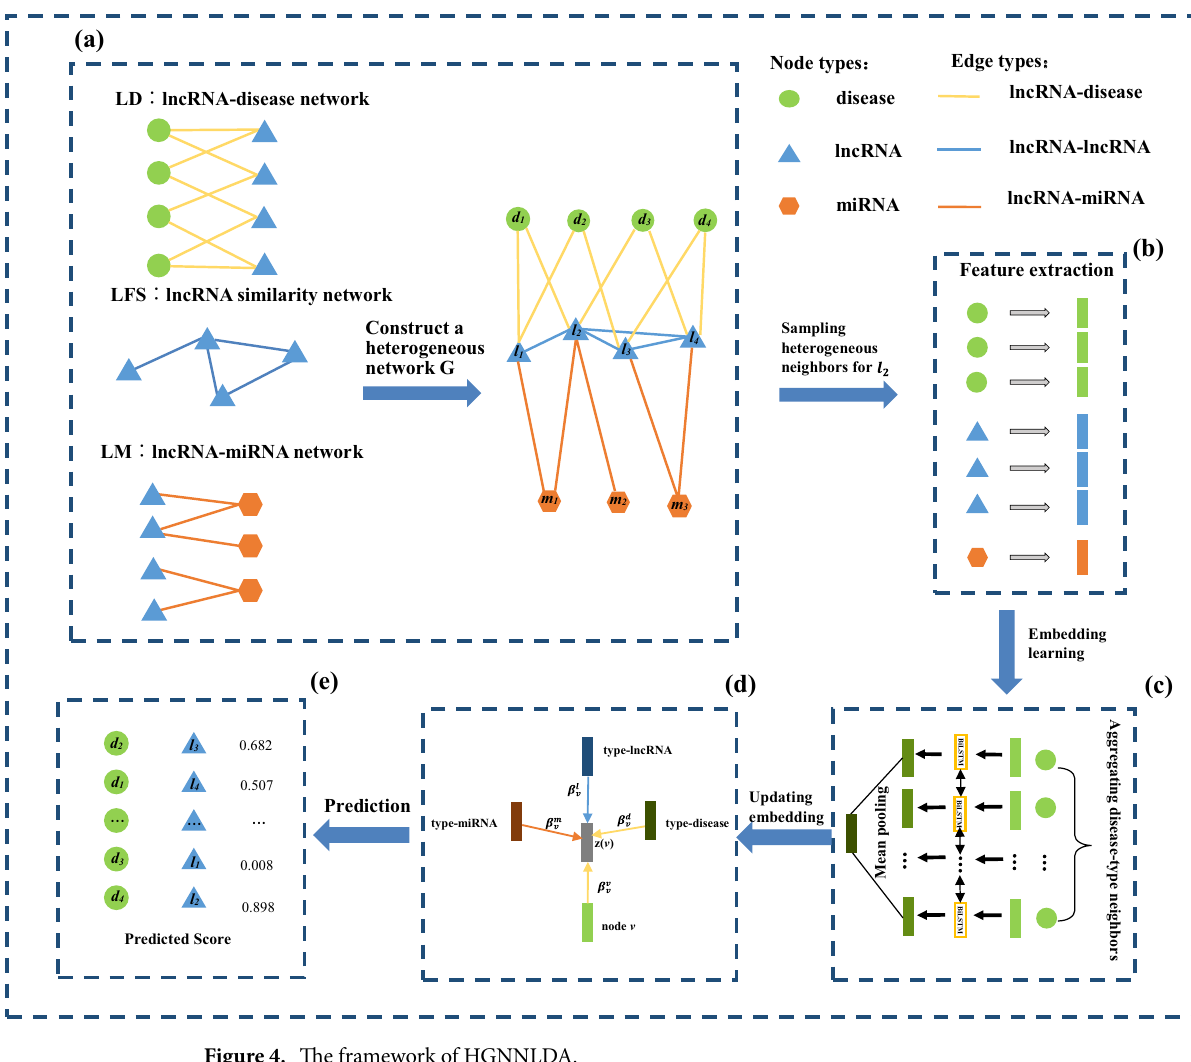
Figure 4. The framework of